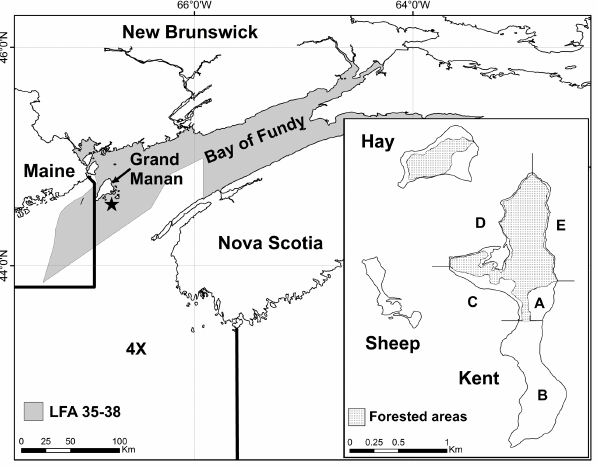
Fig. 1 . Study area with inset map showing study colonies. Star indicates location of study colonies relative to Grand Manan Island. Areas for which regional fisheries landings data were acquired include Lobster Fishing Area (LFA) 35-38 (DFO 2013 a ) and, for herring, the Southwestern Nova Scotia and Bay of Fundy portion of zone 4X delineated by dark lines (DFO 2016). Inset shows surveyed areas for nesting gulls and eiders on Kent, Sheep, and Hay Islands (adapted from Ronconi and Wong 2001), except for the forested areas, which were not surveyed. On Kent Island, direct nest counts were performed for sections A (6.33 ha), C (4.90 ha), D (~2.31 ha; NW shoreline and basin), and E (~1.21 ha; NE shoreline). Transect surveys were conducted in section B (31.79ha). Direct counts were conducted throughout Sheep and Hay